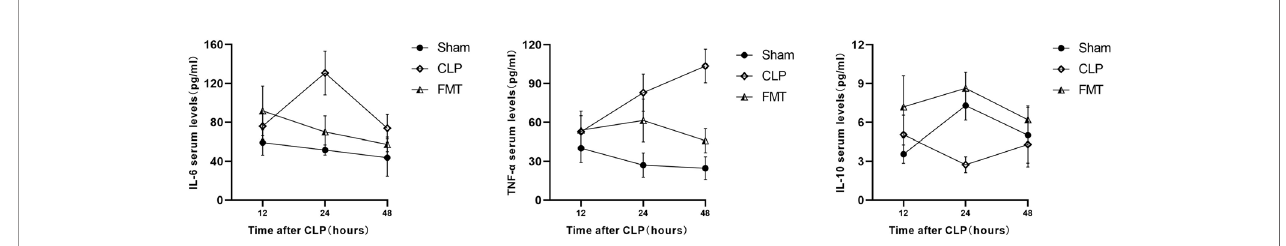
FIGURE 2 | The serum IL-6, TNF- a , and IL-10 among the Sham, CLP, and FMT groups at 12, 24, and 48 h. The concentration of serum IL-6 (pg/mL) and IL-10 (pg/ mL) in the FMT group at 12 h after sepsis modeling were signi fi cantly higher than in the Sham group ( P < 0.05), and there was no signi fi cant difference in TNF- a levels (pg/mL) among the three groups. The serum IL-6 level in the CLP group was signi fi cantly higher than in the Sham group and the FMT group ( P < 0.001) at 24 h. The TNF- a levels in both the CLP and FMT groups were higher than in the Sham group ( P < 0.001 and P < 0.01, respectively). The IL-10 level in the CLP group was lower than in the Sham group and the FMT group ( P < 0.001). The serum IL-6 level in the CLP group was higher than in the Sham group at 48 h ( P < 0.01). The TNF- a level in the CLP group was higher than in the Sham group and FMT group ( P < 0.001). The TNF- a level in the FMT group was higher than in the Sham group ( P < 0.05). There was no signi fi cant difference among the three groups in the IL-10 level at 48